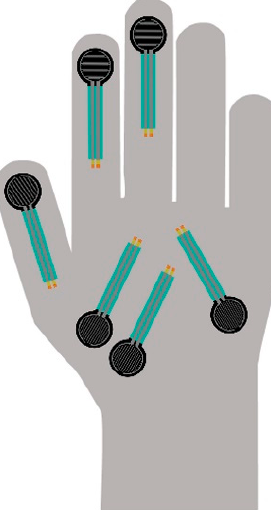
Figure 5. Final sensor arrangement after sensor placement study.